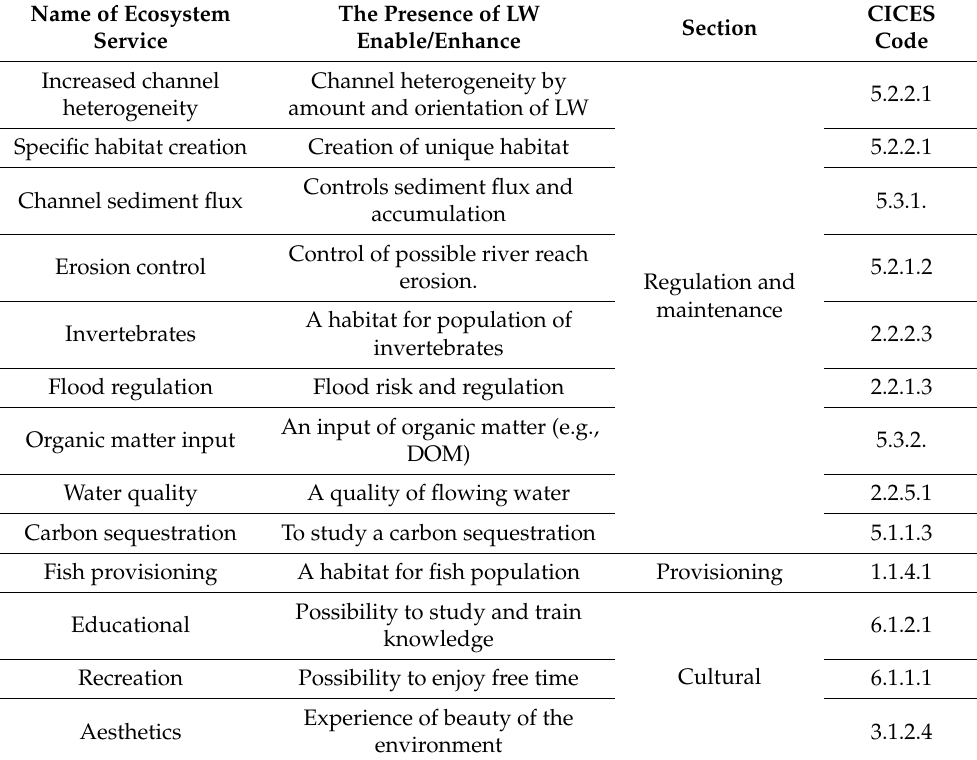
Table 2. The 13 categories of large wood according to the common international classification of ES